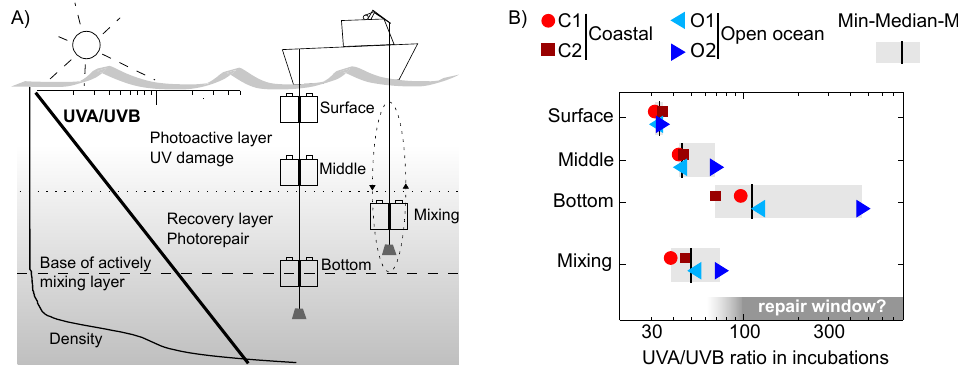
Fig. 1. (a) Illustration of the experimental design. Vertically moving and fixed-depth bottles were incubated in a spectral irradiance gradient, depicted by the UVA/UVB ratio. The dotted and the dashed lines represent the depth of the hypothetical photoactive layer and actively mixing layer, respectively; (b) UVA/UVB in the different treatments in each experiment. The horizontal bar indicates the UVA/UVB window where photolyase repair of bacterioplankton is more efficient, calculated from underwater UVR profiles according to Kaiser and Herndl